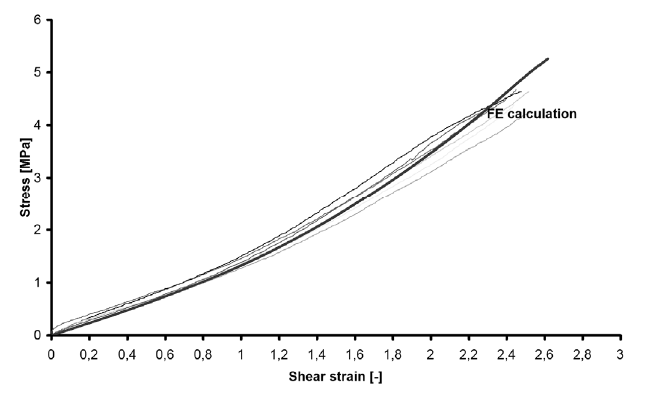
Figure 11: Comparison of FE calculation with experimental results for